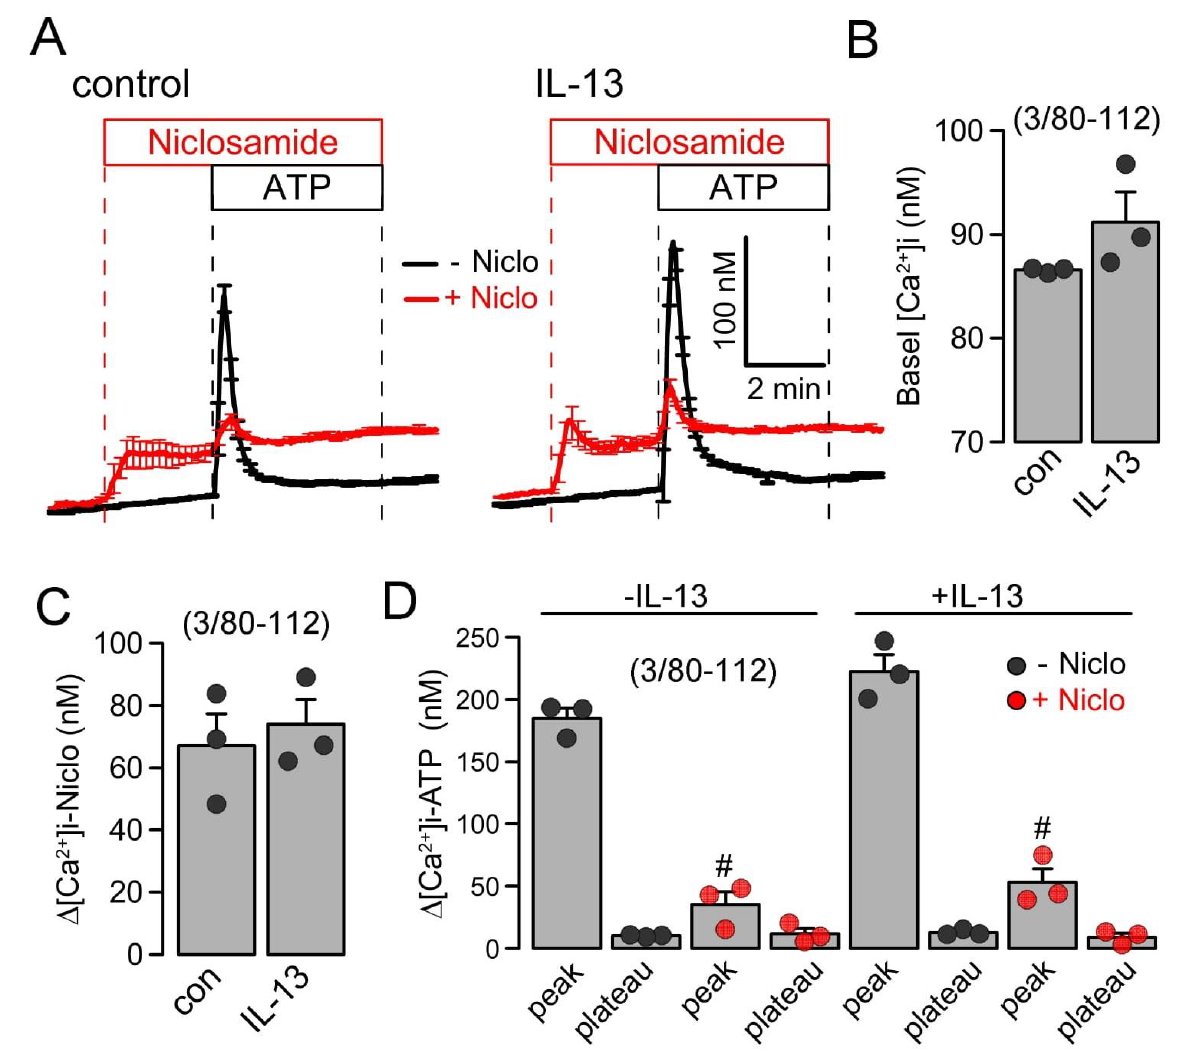
Figure 7. Inhibition of intracellular Ca 2+ signals in Calu-3 cells by Niclo-spheres. ( A ) Summary traces for the intracellular Ca 2+ concentration measured in control Calu-3 cells (left) and cells treated with IL-13 (20 ng/mL/72 h; right). ( B ) Summary of basal Ca 2+ in treated and untreated cells. ( C ) Summary for the increase in intracellular Ca 2+ by niclosamide (5 μM). ( D ) Summary of A TP (100 μM) -induced increase in cytosolic Ca 2+ . IP 3 -induced store release Ca 2+ (peak) but not store operated Ca 2+ influx (SOCE; plateau) was strongly attenuated by niclosamide. Mean ± SEM (number of independent se- ries/number of cells analyzed). # significant difference when compared to control ( p < 0.05; unpaired t -test) or IL-13 ( p < 0.05; ANOVA).